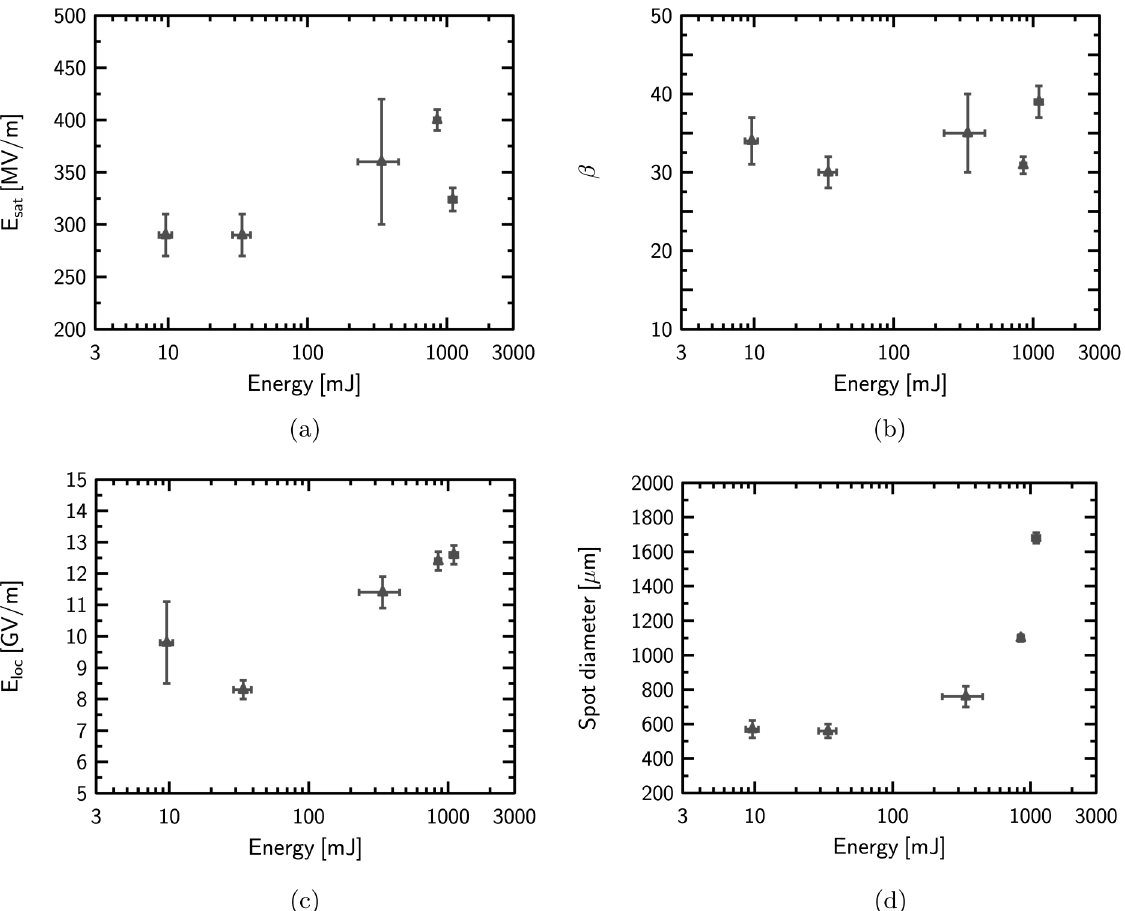
FIG. 8. Breakdown properties of Mo as a function of energy. The energy values correspond to the energy stored in the external capacitor, Ohmic losses on the external circuit components have not been extracted. Each plotted point corresponds to an average of 2–3 measurement series carried out with the same capacitor in processing mode (excluding the processing phase), with up to 250 sparks per series. Vertical errors show the accumulated error of the standard error of the 2–3 series and the average standard error of data points per series. Horizontal errors show the spread in energy due to the uncertainty in saturated field. Note that while the same capacitors were used both for Cu and Mo, the explored energy range lays higher for Mo, because of its higher E sat . (a) Saturated field. (b) Field enhancement factor. (c) Local field. (d) Spot